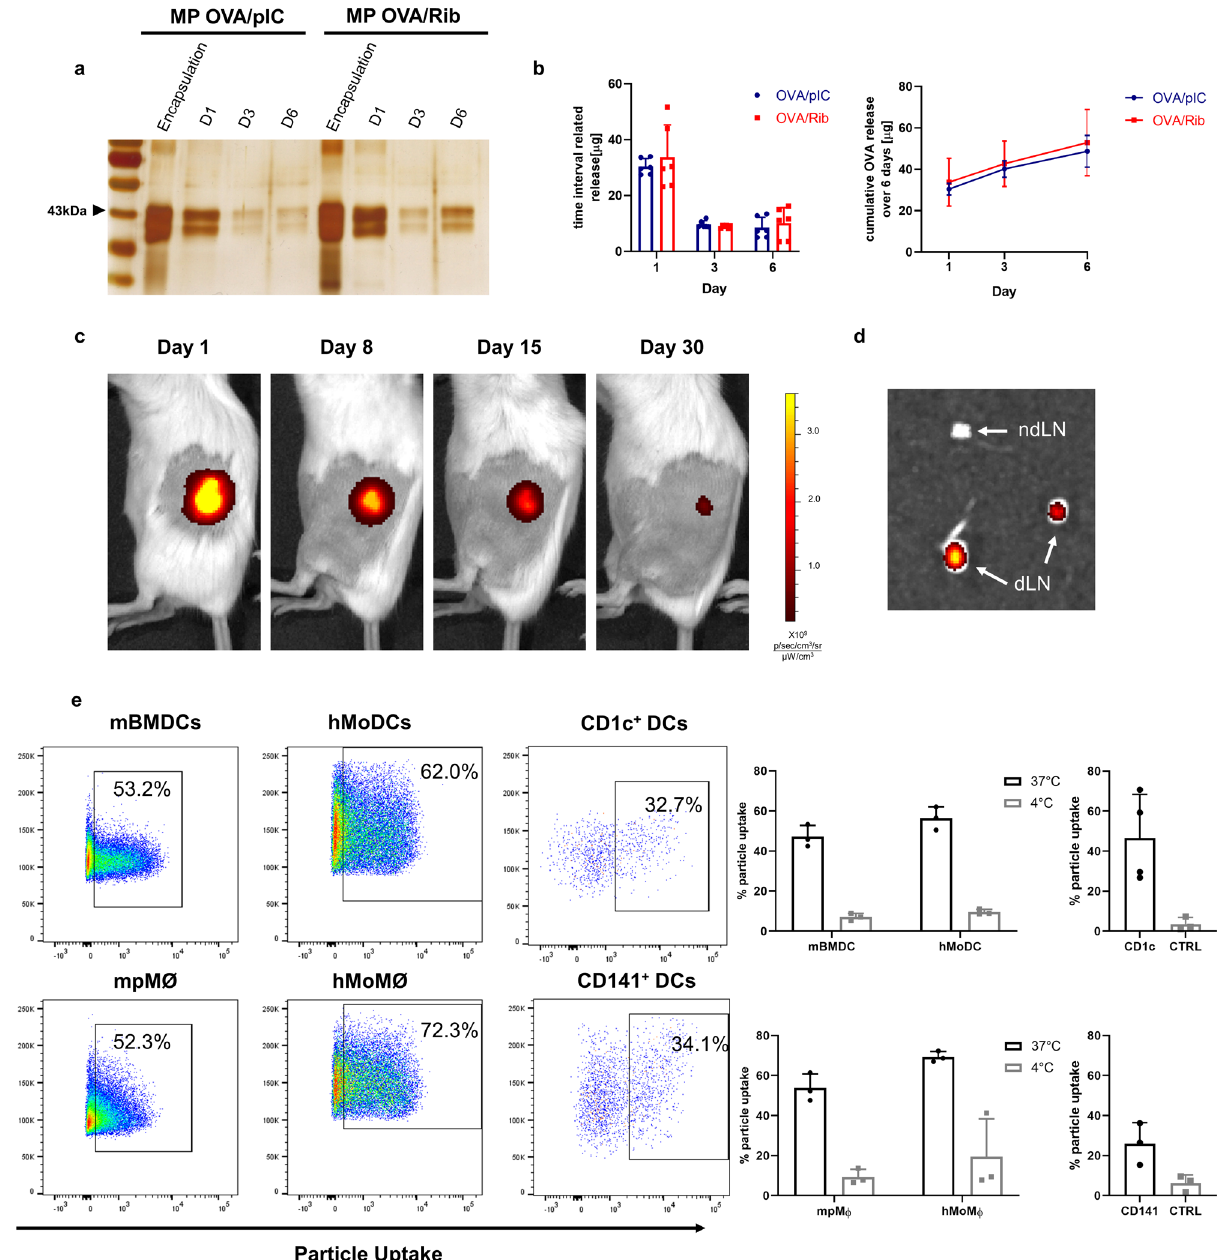
Fig. 2 PLGA-MP exhibit ideal release pro fi les and are ef fi ciently engulfed by human and mouse dendritic cells. a 5 mg MP containing 250 µ g OVA and 2.5 µ g polyI:C (MP-OVA/pIC) or 2.5 µ g Riboxxim (MP-OVA/Rib) were incubated in PBS (pH 7.4) at 37 °C for a total period of 6 days. Amounts of encapsulated OVA and of OVA released from PLGA-MP at indicated time points were determined by SDS-PAGE and subsequent silver staining. Data are presented as means ± SD from three independent experiments. b Encapsulation ef fi ciency and cumulative in vitro OVA release from 5 mg PLGA-MP-OVA/ polyI:C (OVA/pIC, blue circles, n = 6) or PLGA-MP-OVA/Riboxxim (OVA/Rib, red squares, n = 6) over 6 days as analyzed by MicroBCA ™ assay. c Near- infrared (NIR) fl uorescence IVIS ® images of a representative BALB/c mouse s.c. injected with 5 mg fl uorescent MP-QD705/OVA/Rib at the indicated days post-immunization. Scaling of the pseudo-color code is depicted next to the luminescent images. d Ex vivo NIR fl uorescence IVIS ® image of draining popliteal and inguinal LN (dLNs) and of the contralateral non-draining LN (ndLN) of a representative mouse 6 days after s.c. immunization with MP- QD705/OVA/Rib. e Percentage of fl uorescent particle internalization 6 h after incubating DCs with 10 µ g/ml MP-QD705/OVA/Rib at 37 °C (black circles) or 4 °C (no uptake control, gray squares) was assessed by fl ow cytometry. Approximately 60% of PLGA-MP were ef fi ciently engulfed by mouse bone marrow-derived DCs (mBMDCs, n = 3) or thioglycolate elicited peritoneal macrophages (mpMØ, n = 3), as well as by in vitro differentiated human monocyte-derived DCs (hMoDCs, n = 3) or monocyte-derived macrophages (hMoMØ, n = 3). PLGA particle uptake by human myeloid DCs was assessed using fl ow cytometry by gating on QD705 + CD1c + ( n = 4) and QD705 + CD141 + cells ( n = 3) (black circles) after incubation of fl uorescent microparticles with 10 7 CD14-negative PBMCs. CD1c-negative ( n = 4) or CD141-negative cells ( n = 3) served as control (CTRL, gray squares). Data are presented as means ± SD and are derived from at least two independent experiments with a similar